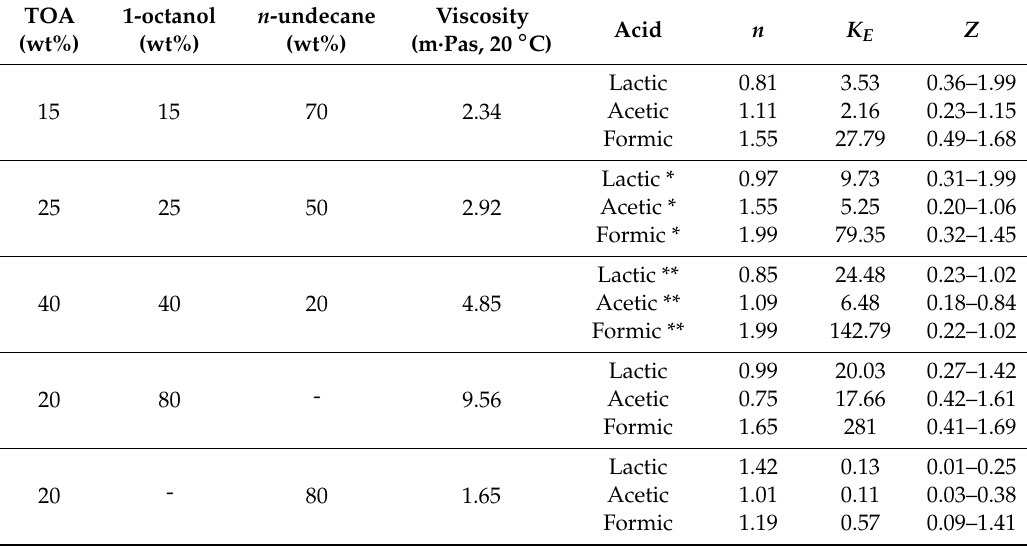
Figure 4. Determination of the extraction equilibrium constant and the degree of acid association of lactic acid (T = 25 °C; ambient pressure) according to Equation (10). Table 3. Summary of calculated K E and n for reactive extraction of lactic acid, acetic acid and formic acid with di ff erent ratios of TOA:1-octanol and n -undecane; c acid,initial = 0.2–1.0 mol / L; T = 25 ◦ C; ambient pressure; solvent:water =